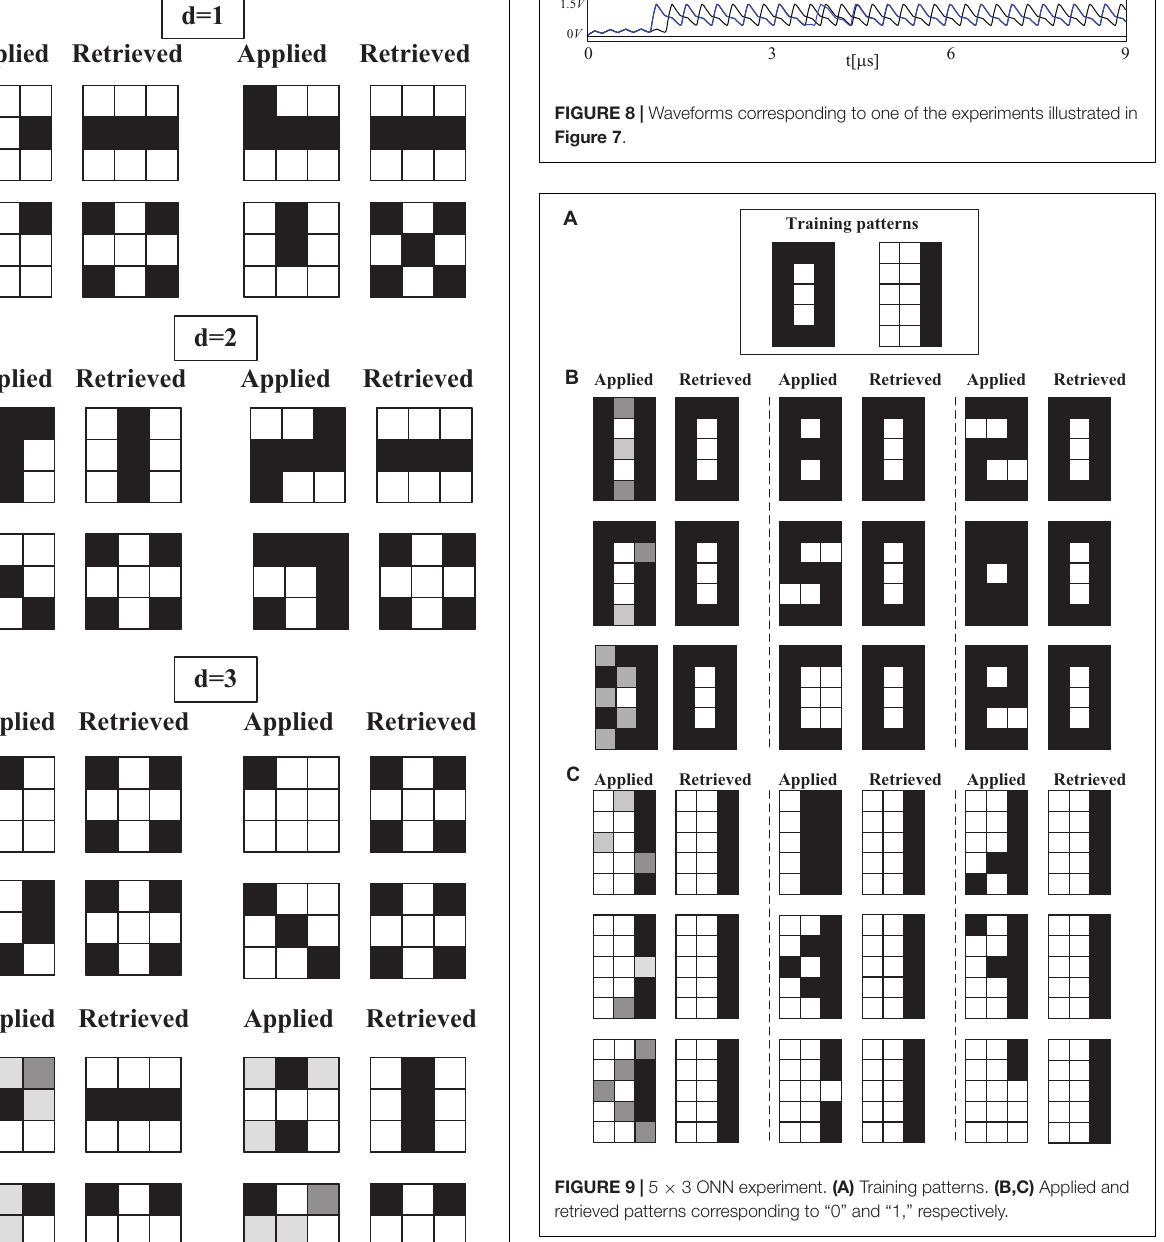
one test pattern are correctly retrieved. In fact, the one that has not been recovered, the vertical line with a missed pixel in Figure 7B , is at distance of 1. However, in order to fairly analyze the pattern recognition performance of the proposed ONN, it is important to be aware of the